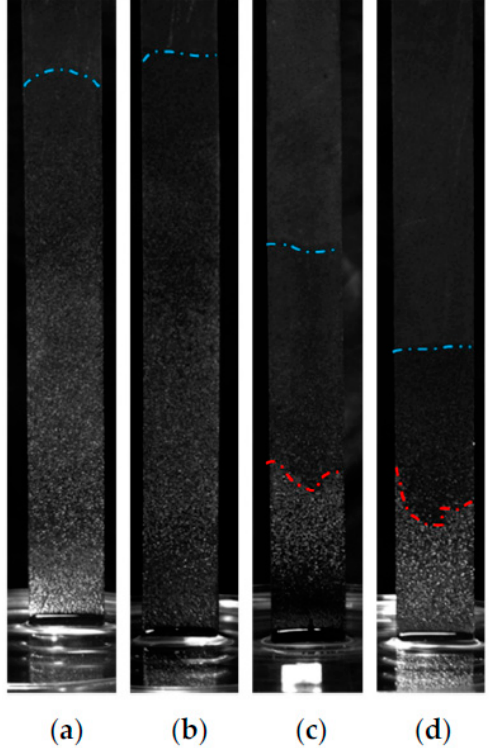
Figure 11. Images of capillary rise process of the four copper foams with different thicknesses at 1000 s: ( a ) 0.8 mm; ( b ) 1.0 mm; ( c ) 1.5 mm; ( d ) 2.0 mm, red line is the boundary between the saturated and unsaturated zone, and bule line the boundary between the unsaturated zone and the dry